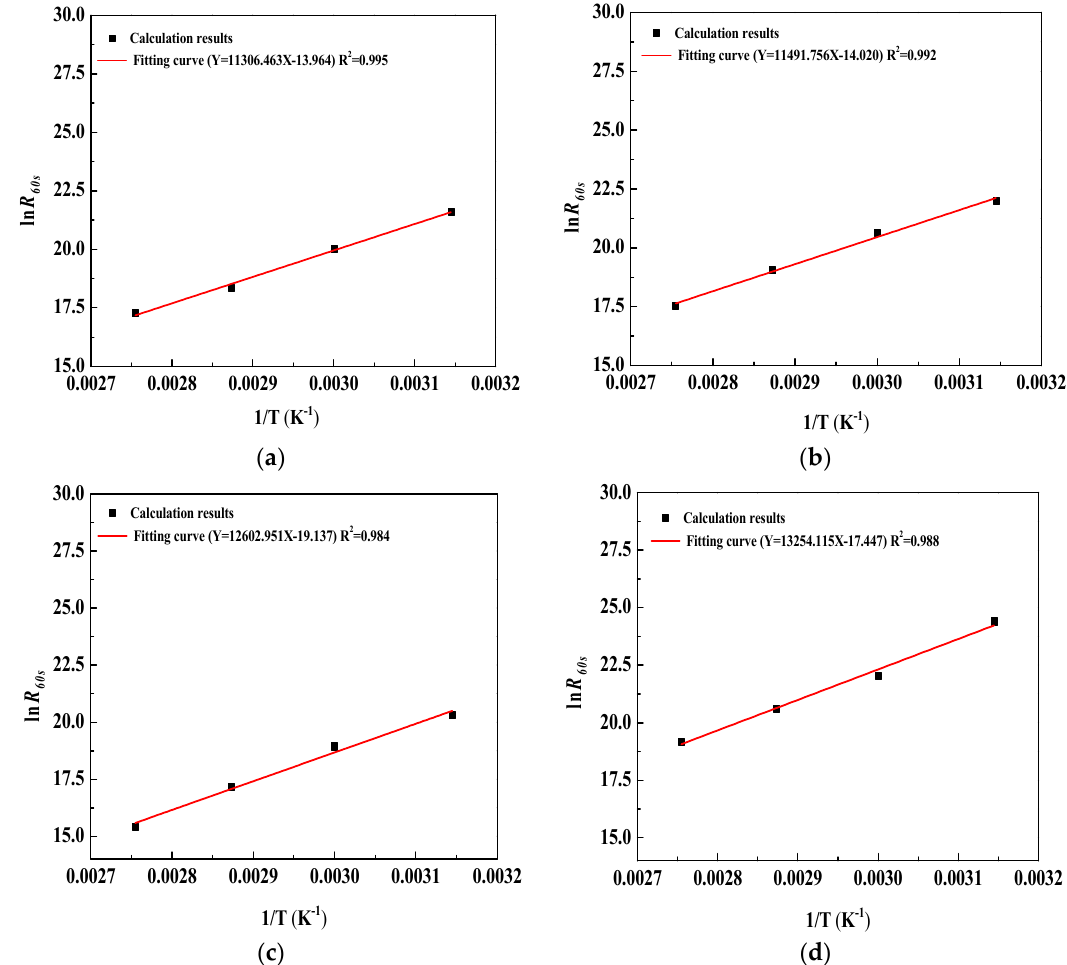
Figure 12. Relations between ln R 60s and 1/T. ( a ) Ageing 0 day (DP = 1285), moisture content 4.02%; ( b ) Ageing 8 days (DP = 994), moisture content 2.82%; ( c ) Ageing 21 days (DP = 841), moisture content 3.71%; and, ( d ) Ageing 42 days (DP = 415), moisture content 1.17%.